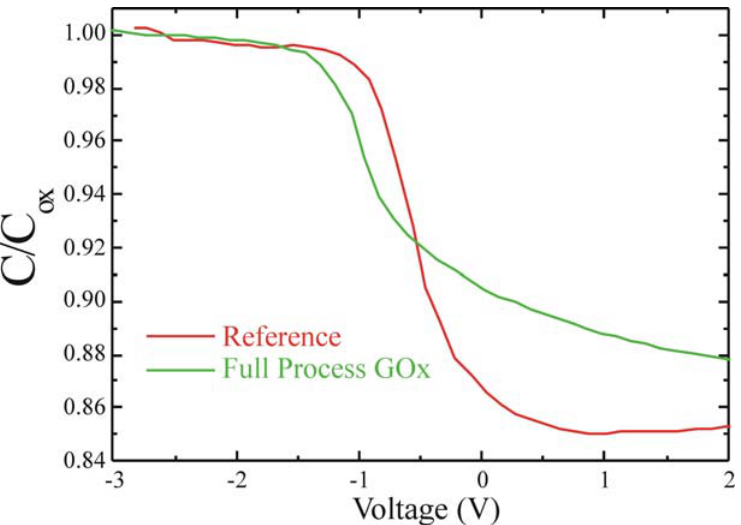
C-V measurements of the reference sample (red line) and of a GOx immobilized sample (green